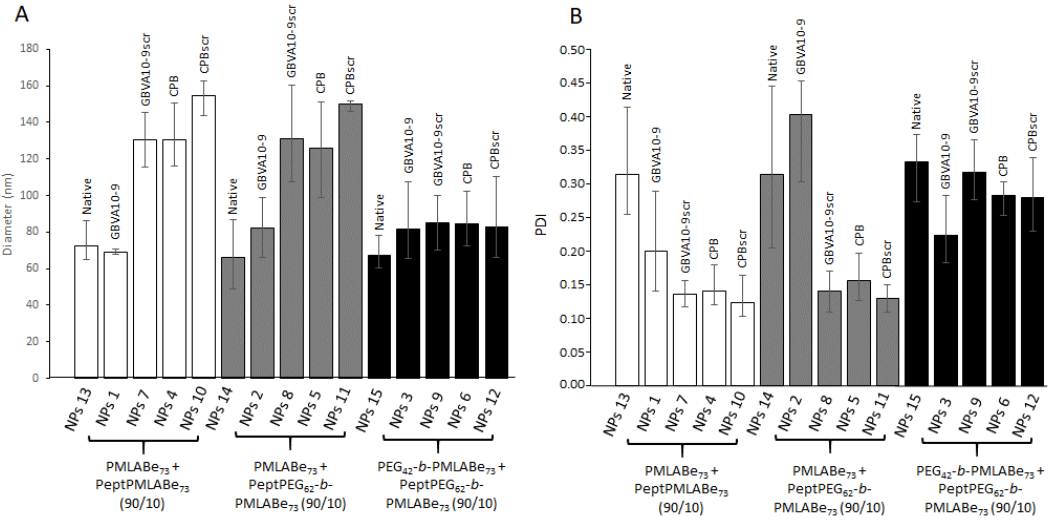
Figure 6. Variations in: ( A ) diameter, and ( B ) dispersity of peptide-decorated and native